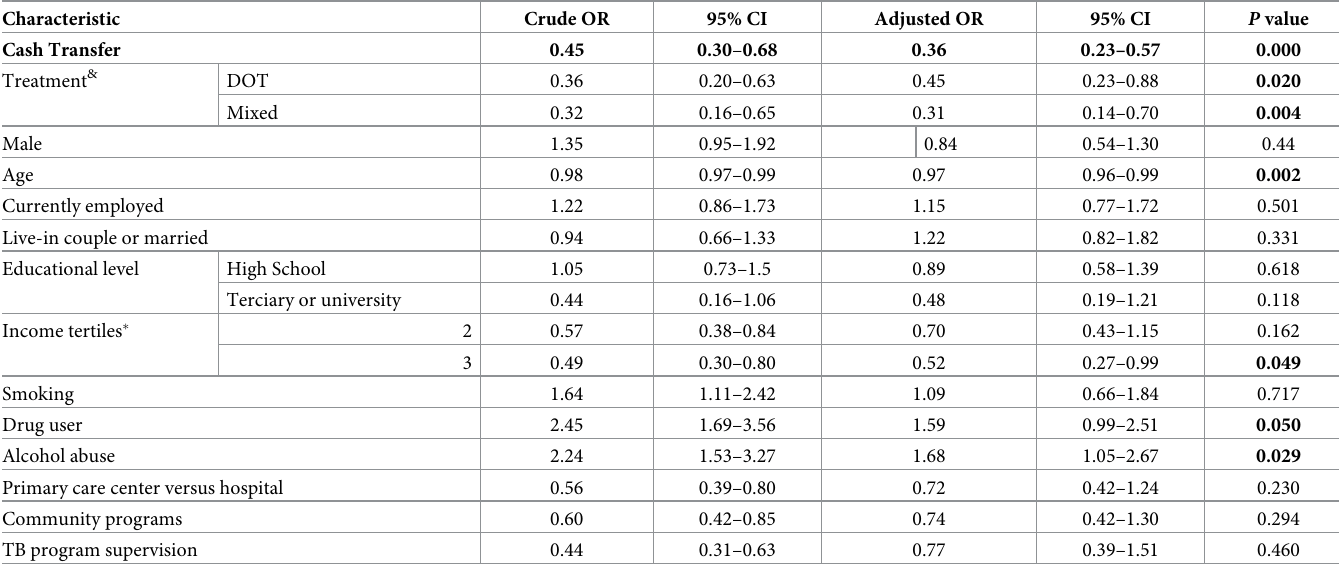
Table 2. Multilevel model. Factors associated to incomplete treatment